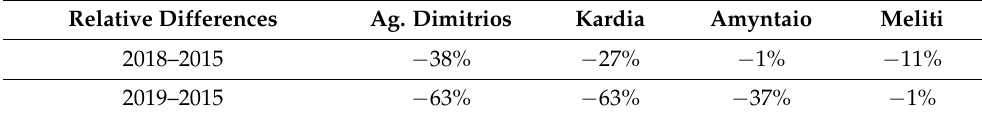
Table 3. Relative differences between a posteriori emissions estimated in the summer of 2018 and 2019 and a priori emissions used for the simulations over the four grid-pixels. Relative Differences Ag. Dimitrios Kardia Amyntaio